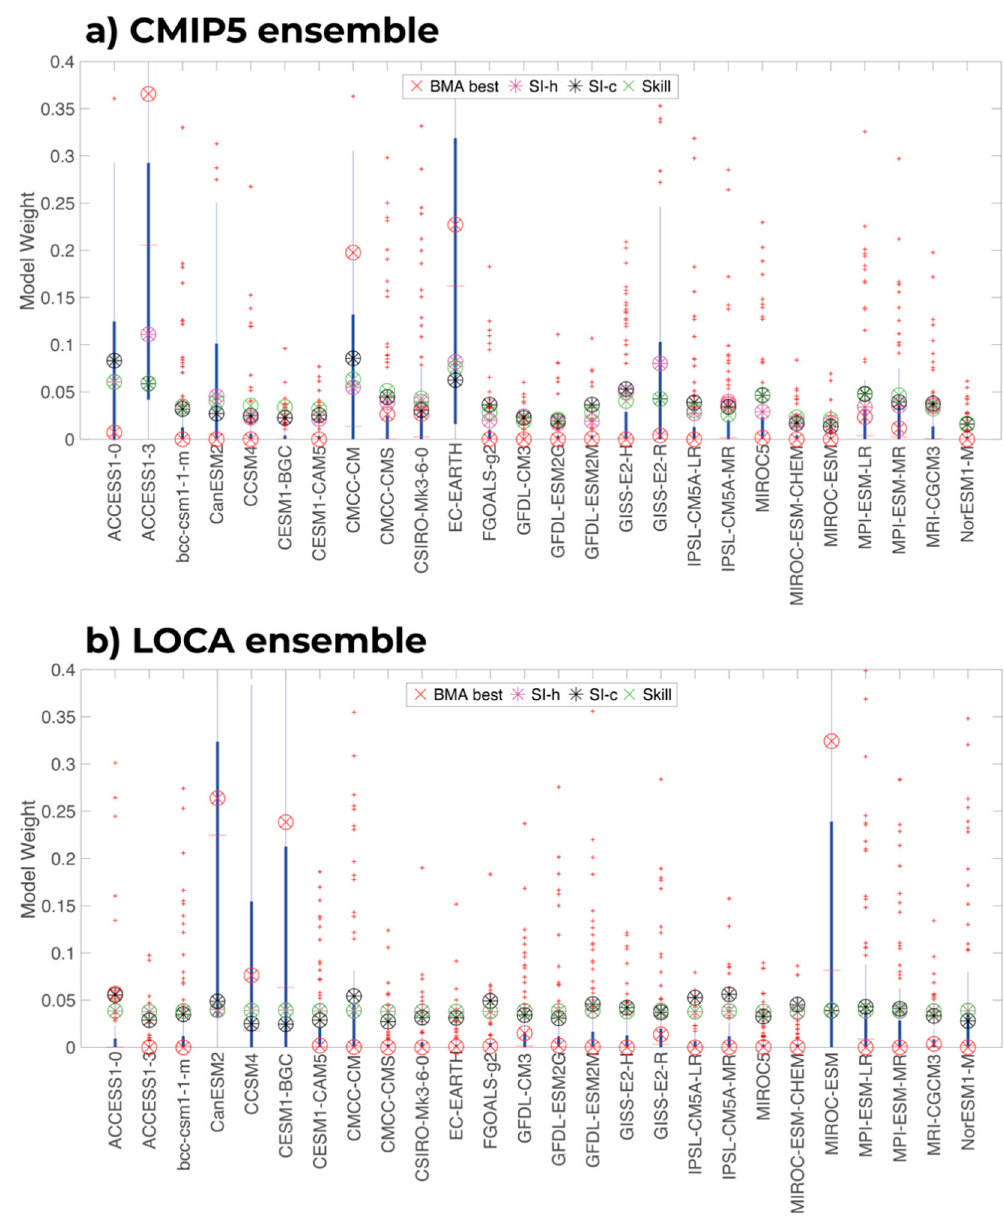
Figure 4. ( a ) BMA best, SI-h, SI-c and Skill weights for the CMIP5 ensemble; ( b ) BMA best, SI-h, SI-c and Skill weights for the LOCA ensemble. Boxplots in the background are the weights across all BMA simulations. BMA